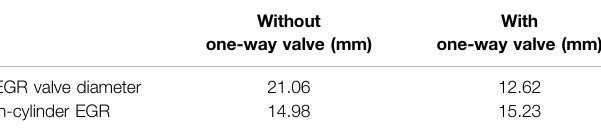
TABLE 3 | EGR actuator position and the in-cylinder EGR at 3,000 rpm and 13 bar BMEP.